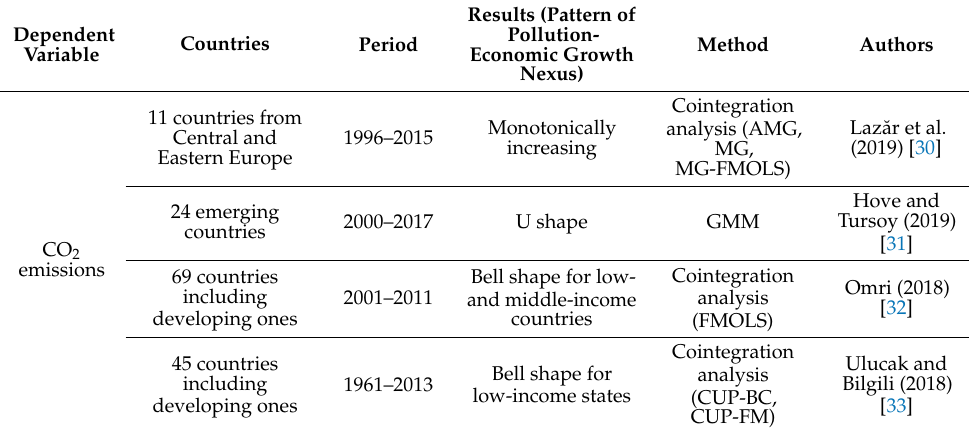
Table 1 indicates only four proxies for pollution: CO 2 , GHG, SO 2 and ecological footprint. Table 1. Studies in the literature based on EKC for developing